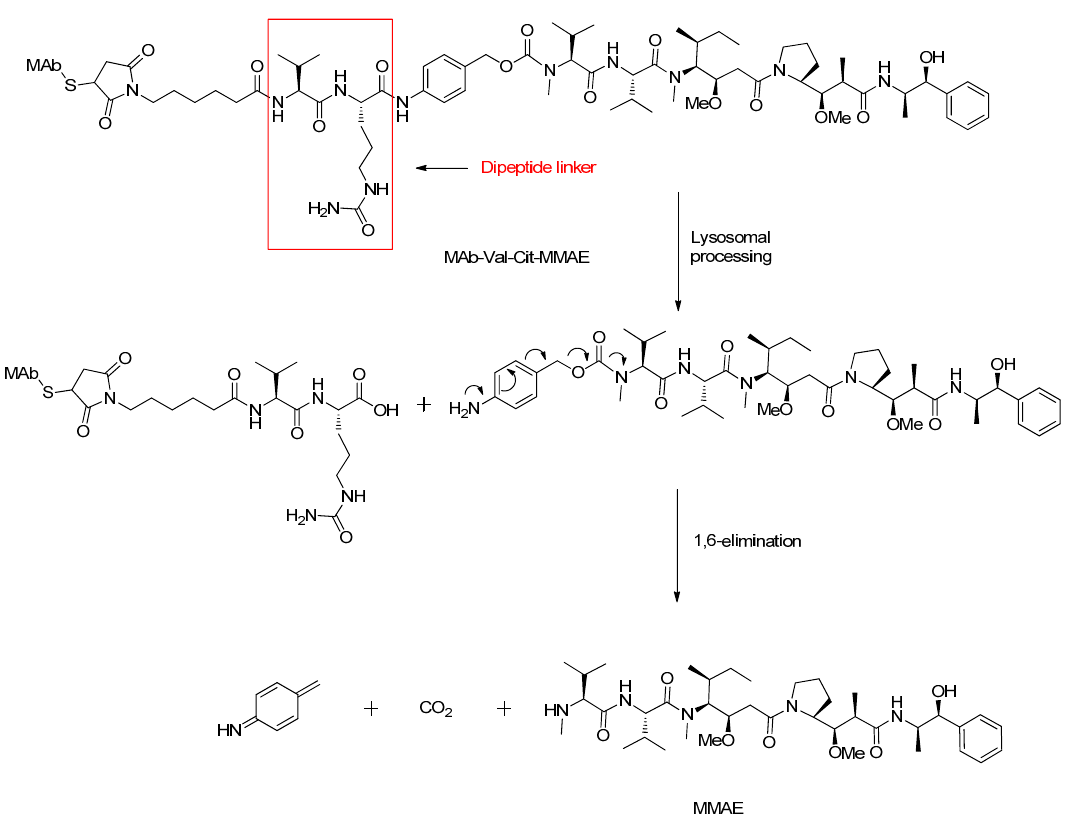
Figure 11. The structural formula of MAb-Val-Cit-MMAE (SGN-35) and the supposed cleavage mechanism after internalization into the lysosome. Adapted from reference [49,76].